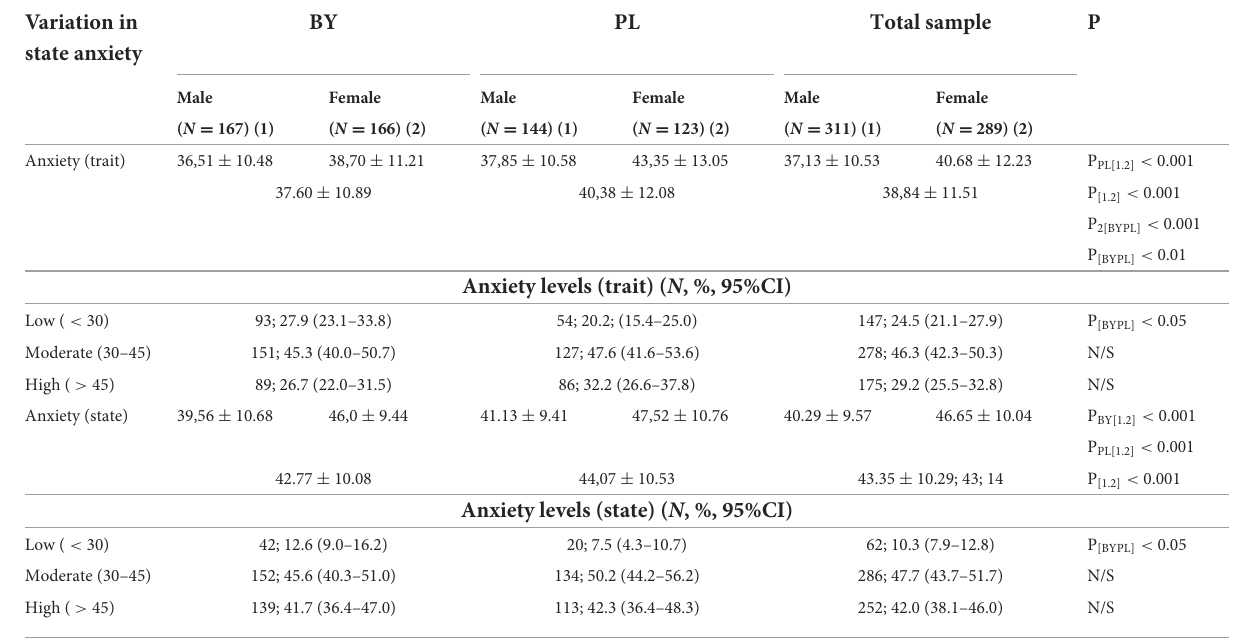
TABLE 4 Comparison of trait anxiety and state anxiety scores and country and gender of the respondents (M ± SD). Variation